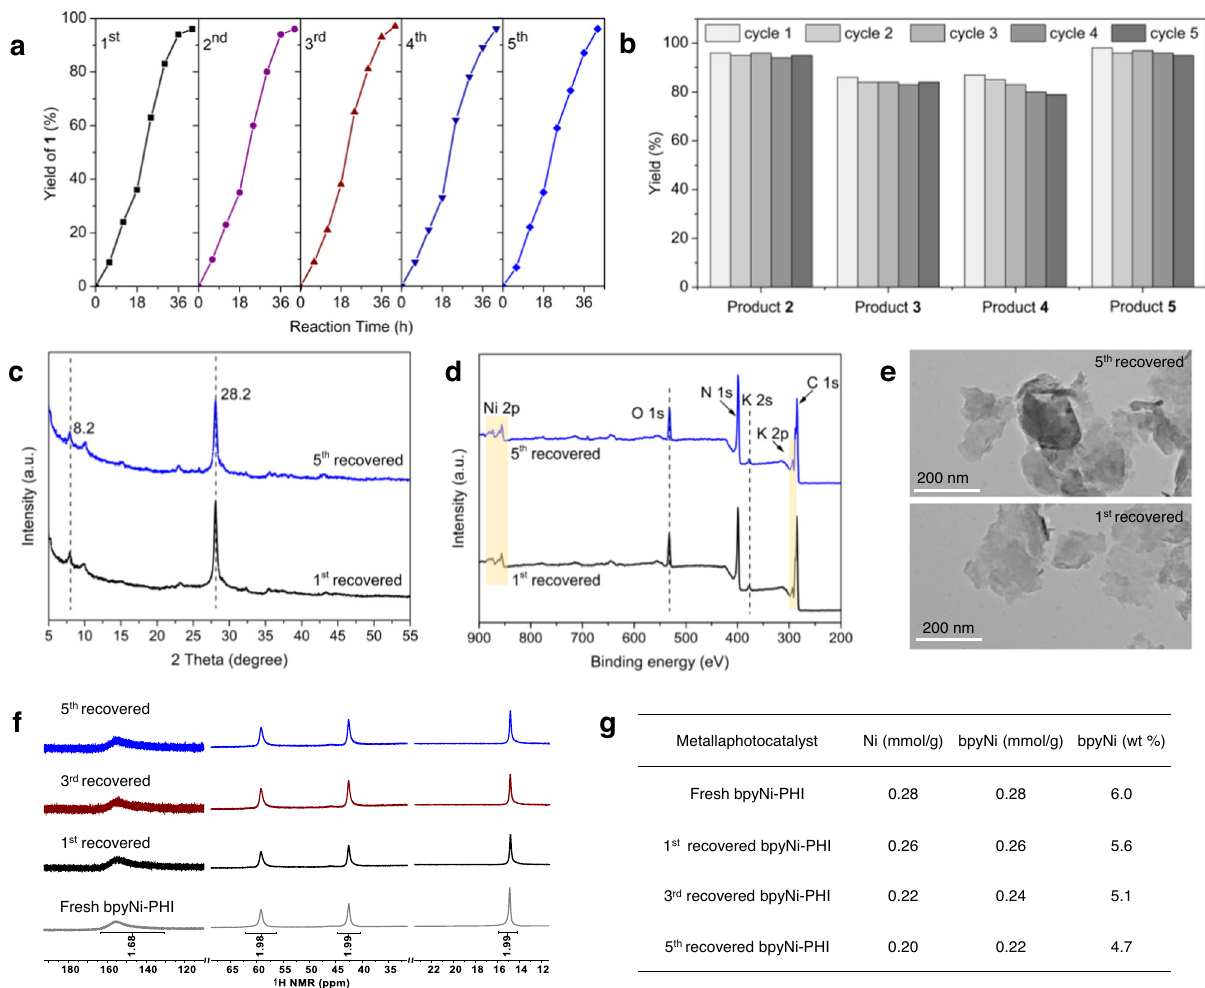
Fig. 5|Recyclabilityand leaching test.a Kineticpro fi leof thephotocatalyticC – P coupling (0.2mmol scale with 10mg of bpyNi-PHI) over fi ve catalytic cycles. b Catalyst recycling (for fi ve catalytic cycles) of the C – N, C – O, and C – S coupling. c XRD patterns. d XPS survey spectra. e TEM images of recovered